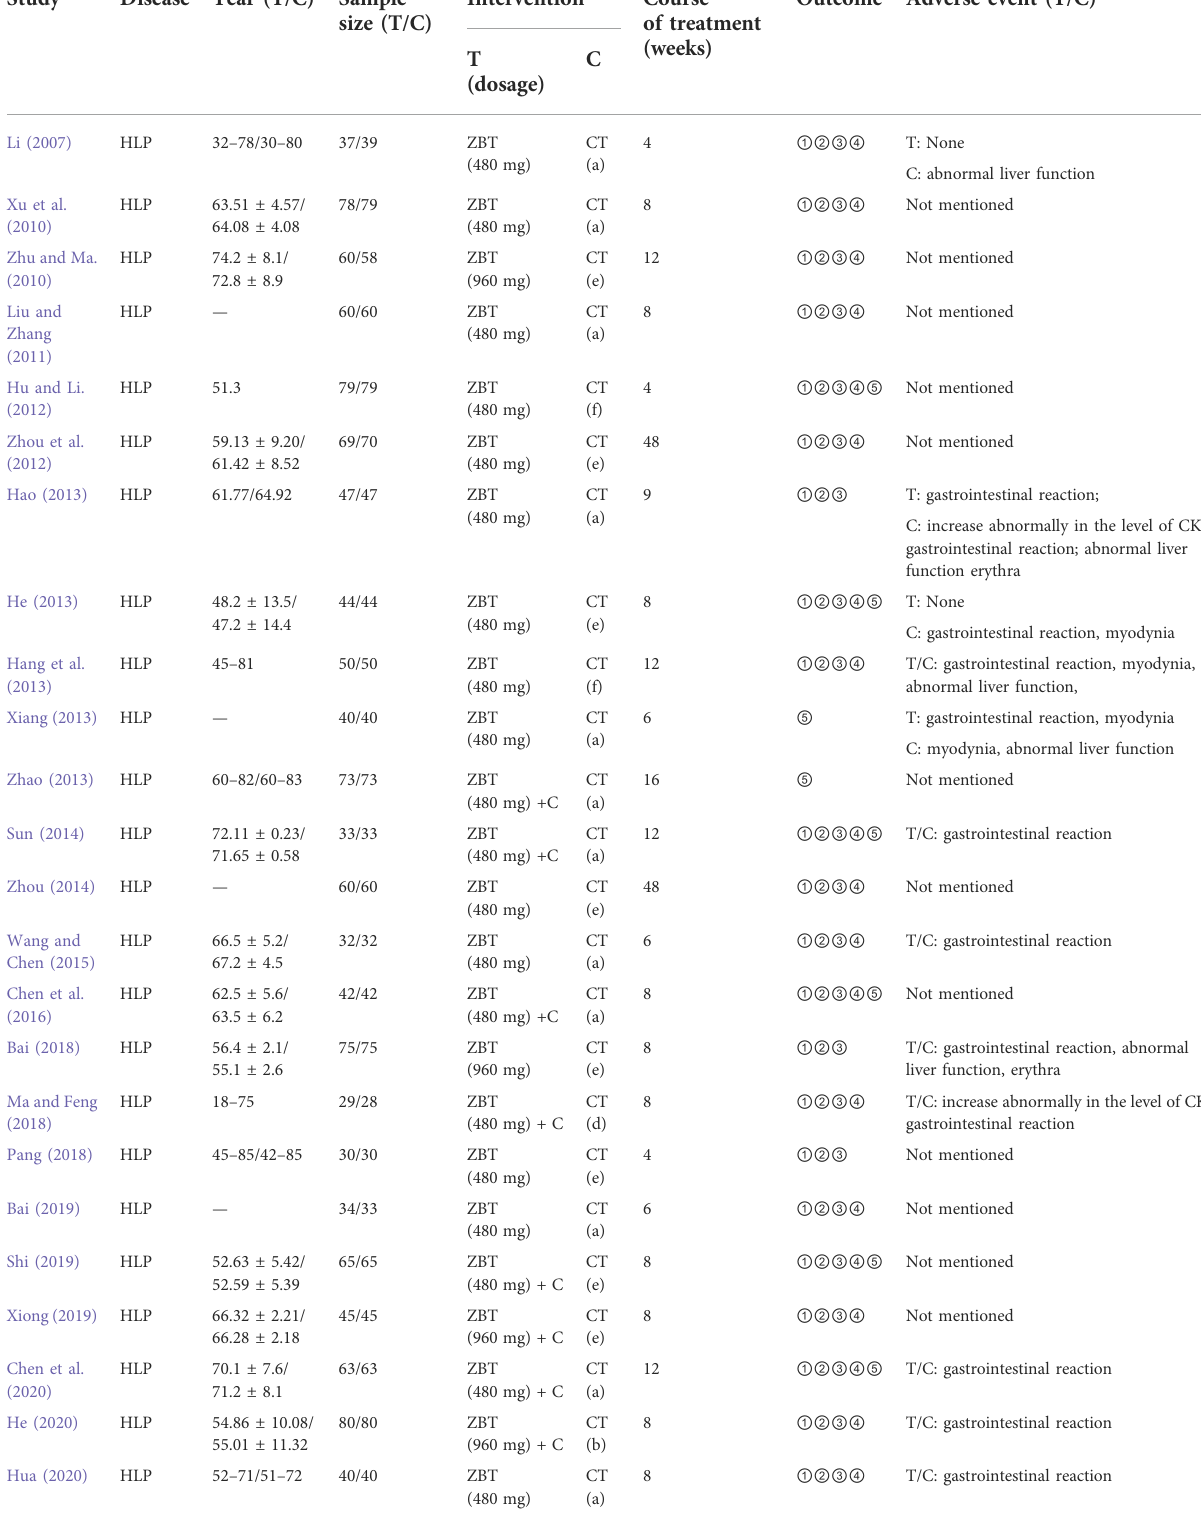
TABLE 1 Basic characteristics of the included